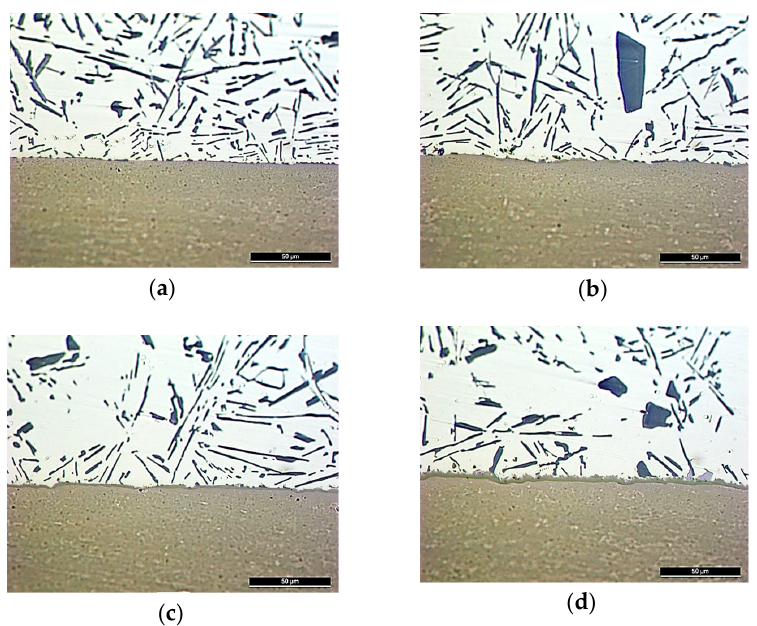
Figure 16. Light microscope images of a brazed joint (13/585) with both initial load + USV, where ( a ) to ( d ) are from a point close to the edge to the highest thickness of the intermetallic at the interface.